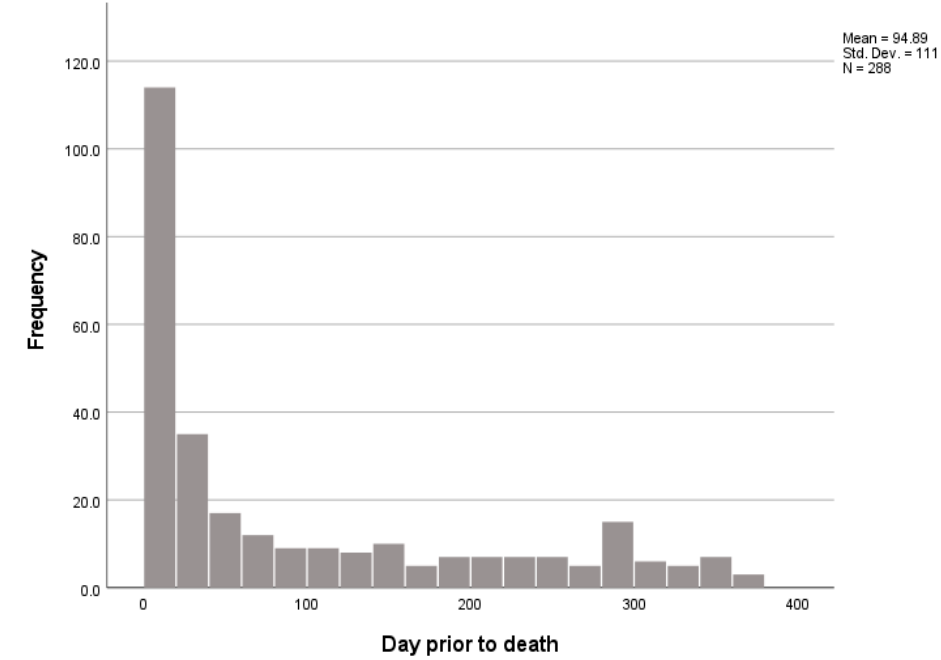
Figure 1. Histogram of frequency of referral to acute care, related to days prior to death. N—number; Std. Dev.—standard deviation.